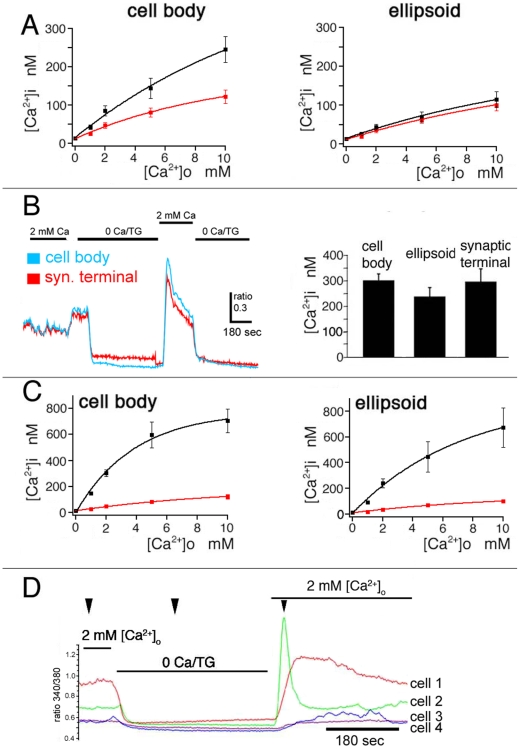
SOCE in cone photoreceptors.(A) Baseline [Ca2+]i in cones is a function of [Ca2+]o; red trace represents cells with intact stores; black trace represents the same cells following exposure to 1 µM thapsigargin (TG). Thapsigargin treatment facilitates plasma membrane Ca2+ entry in the cell body (left panel) more than in the ellipsoid regions (right panel). (B) Ca2+ store depletion modulates Ca2+ entry in all compartments of the cone inner segment. Left panel: simultaneous [Ca2+]i recording from cell body (blue trace) and synaptic terminal (red trace) during store depletion in Ca2+-free saline and following re-addition of 2 mM Ca2+ reveals Ca2+ overshoots in both compartments. Right panel: Summary of Ca2+ overshoot data for synaptic terminal, cell body and ellipsoid [Ca2+]i elicited by the depletion protocol. (C) Superposition of [Ca2+]i baseline (in the presence of TG; red trace) and Ca2+ overshoots (following store depletion; black trace) for the cell body (left panel) and ellipsoid (right panel). (D) Four single cones under control conditions, during store depletion and during the Ca2+ overshoot phase (arrowheads). Cytosolic [Ca2+]i in all four cells reaches the same level during store depletion but exhibit different amplitude and kinetics during the Ca2+ overshoot phase.